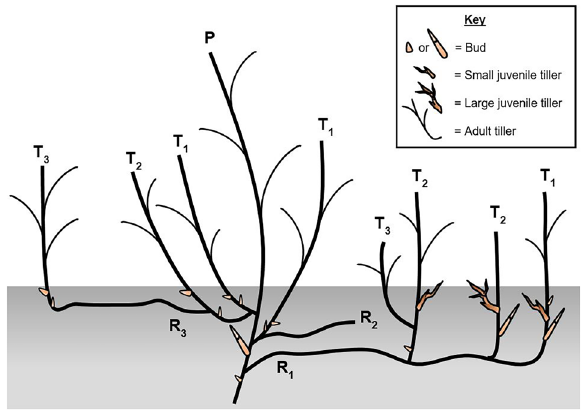
Figure 6. Conceptual diagram of live propagules and tiller and rhizome classification according to generations. R = rhizome, T = adult tiller, P = parent, 1 = primary generation, 2 = secondary generation, 3 = tertiary